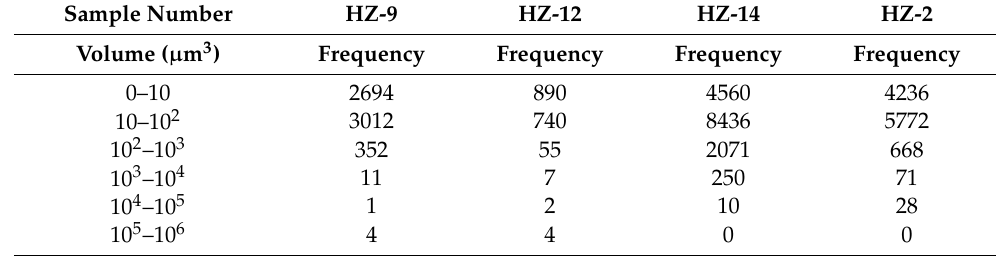
Table 4. Test results of the pore volume of the carbonate rock samples in the Huize lead–zinc deposit.